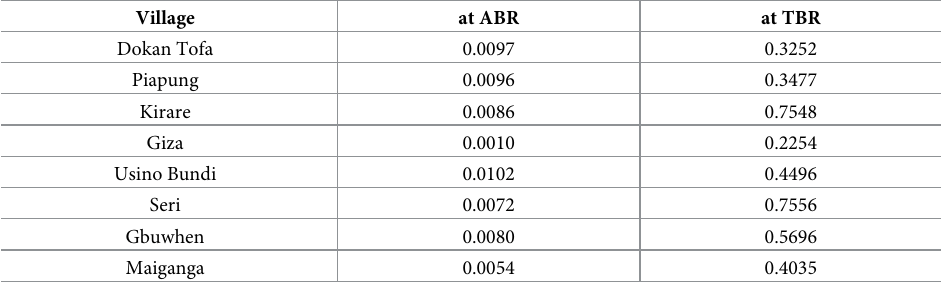
Table 4. Site-specific mf breakpoints representing 95% elimination probability at either ABR or